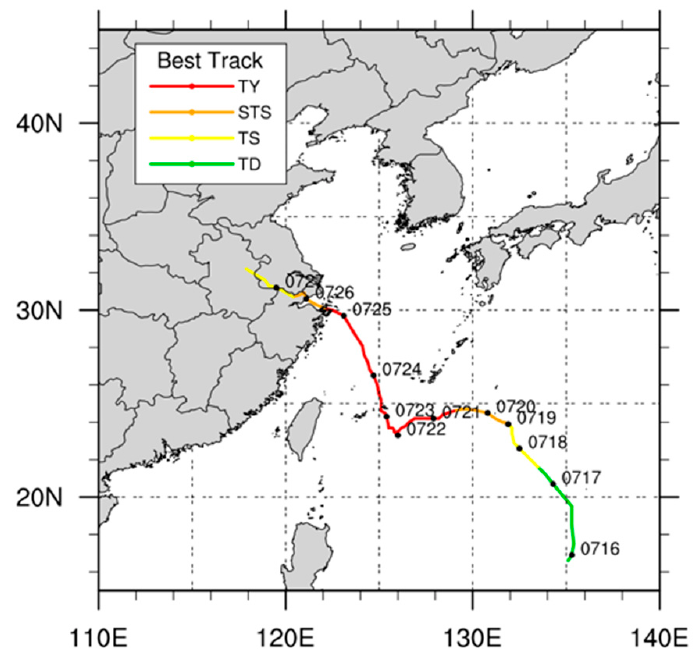
Figure 1. The best track of the In-Fa from JMA.